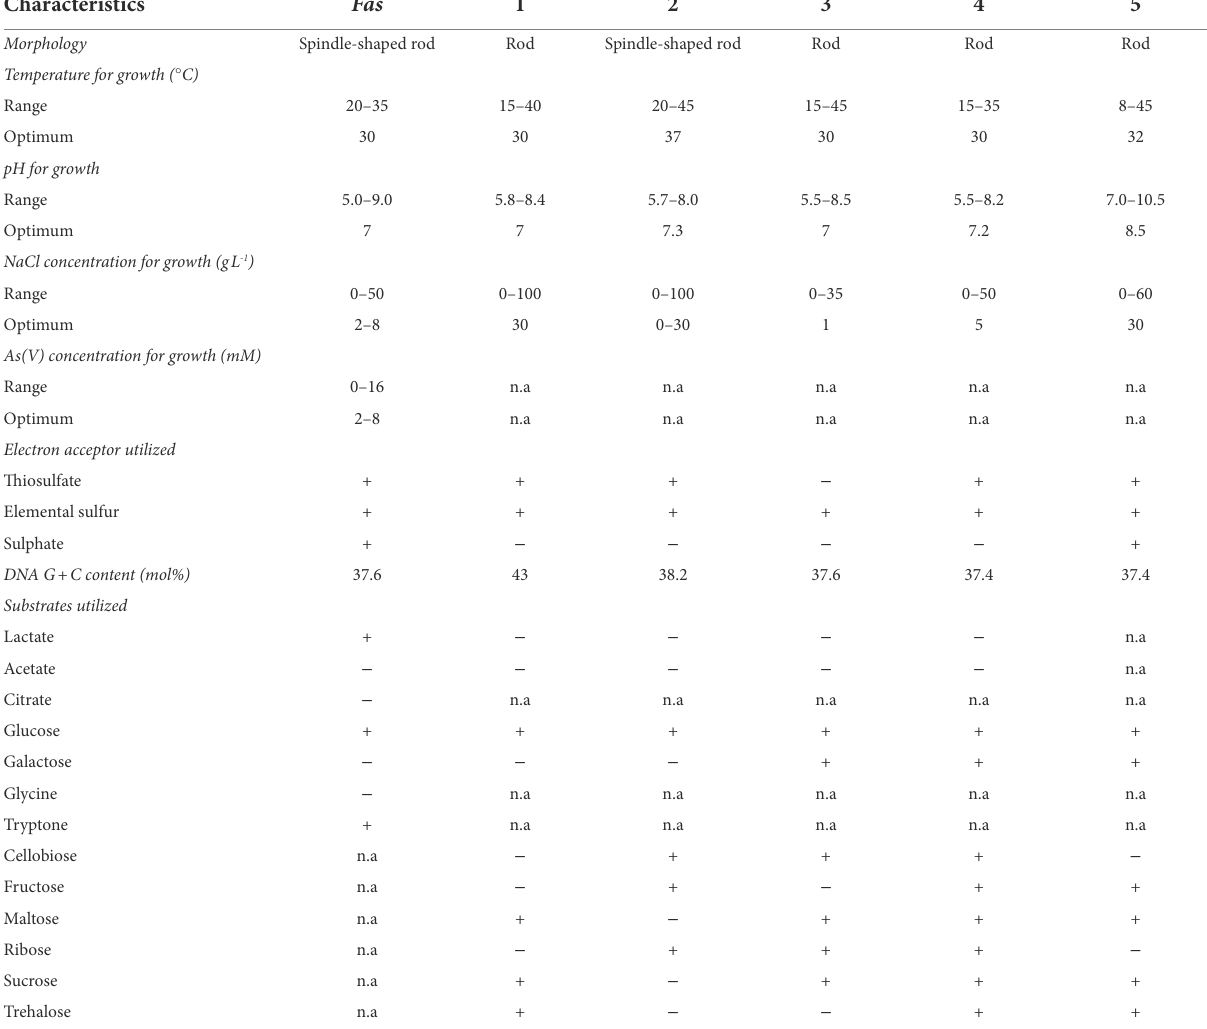
TABLE 1 Comparison of the characteristics of Fusibacter sp. strain 3D3 and other Fusibacter type strains from literature, with sequenced genomes.